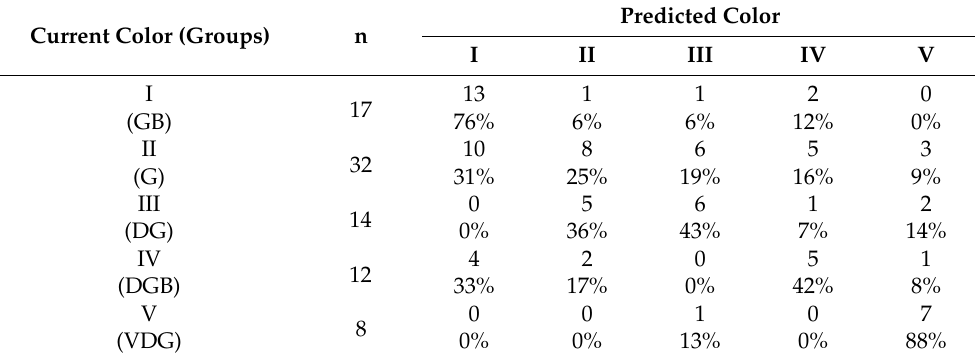
Table 2. Congruence matrix between the color groups of road dust based (discriminant variables) and those groups formed based on the presumably contaminating elements (classification variables). Current Color (Groups)